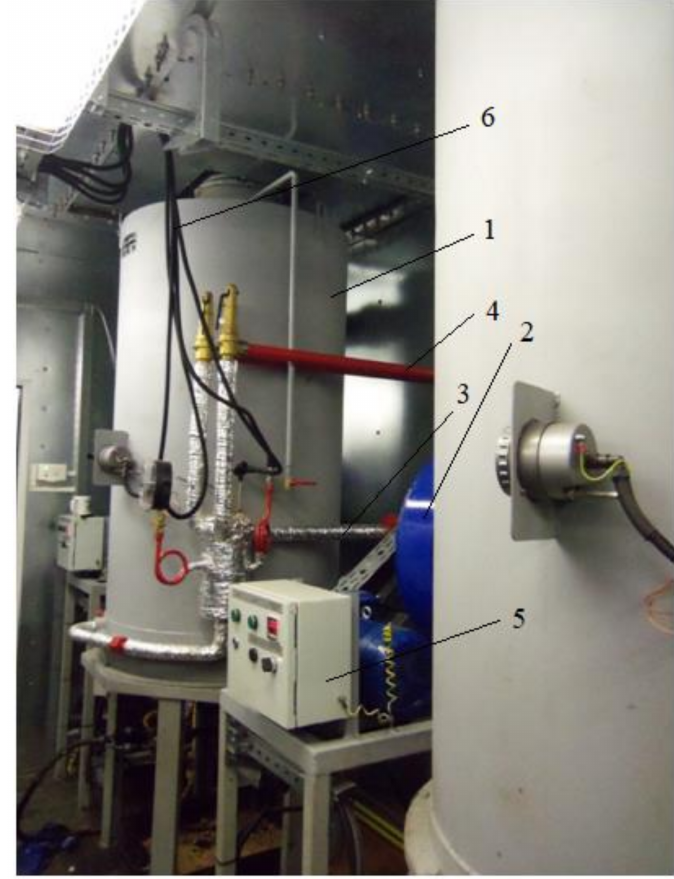
Figure 5. Research stand for the study of vapor formation and movement of liquid and steam in a steam generator of the coil type: 1—the body of the steam generator, inside which the coils are located, 2—fan, 3—water supply pipeline, 4—pipeline of superheated steam obtained in, 5—control unit, 6—system for measuring the main parameters in the steam generator.